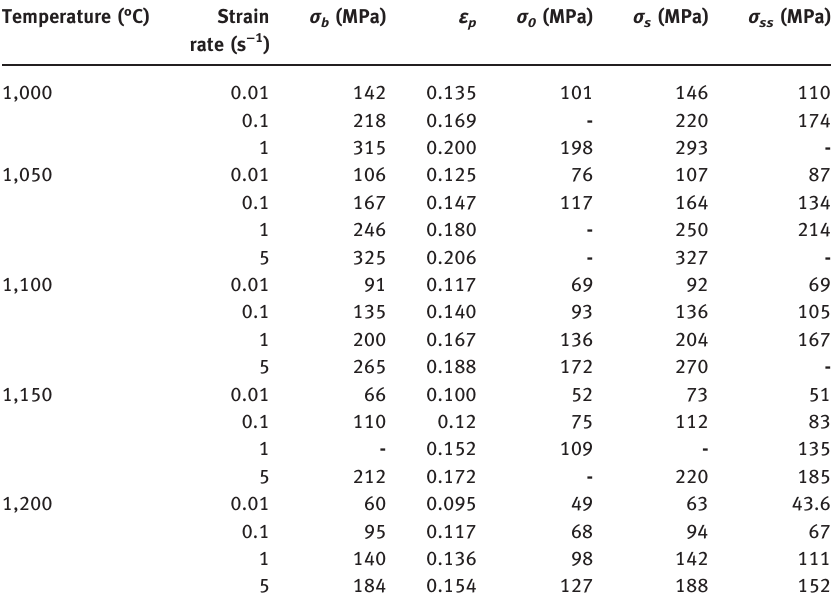
Table 2: Values of parameters of the flow stress curves under different deformation conditions. Temperature (°C)